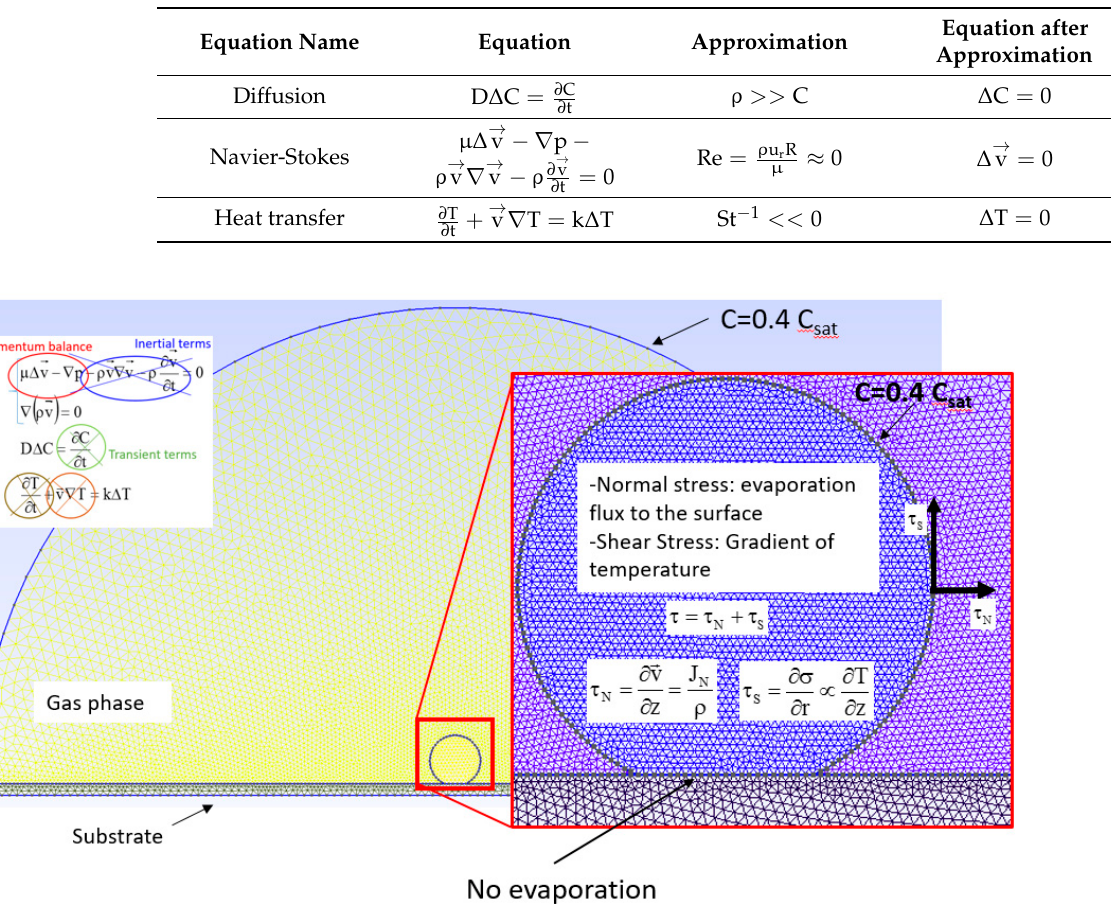
Figure 3. Illustration of the model and boundary conditions. Table 1. Partial differential equations, approximations, and equations after approximations.